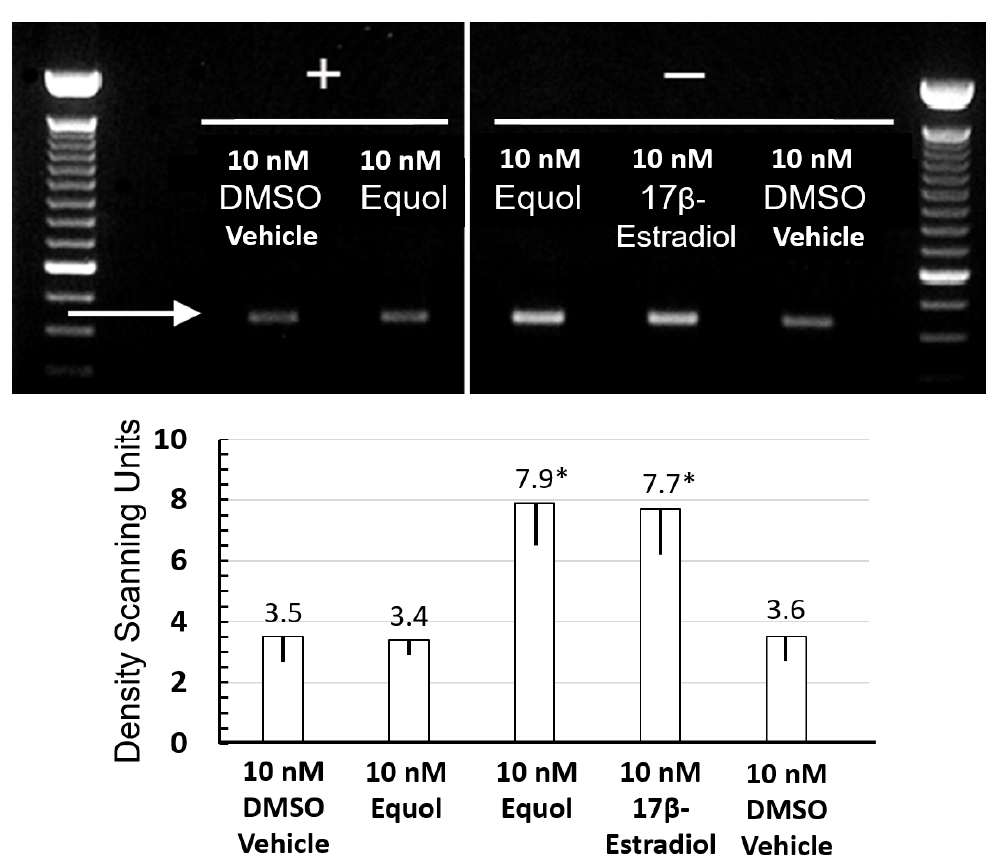
Figure 4. RT-PCR analysis of elastin gene expression in short-term (four days) human monolayer fibroblast cultures in the presence (+) or absence ( − ) of phenol red dye after treatment with 10 nM DMSO vehicle (control) or 10 nM Equol or 10 nM 17 β -Estradiol (top portion). The white arrow indicates the position of the 431 bp predicted elastin gene product. Molecular size ladders are shown on the far left and far right lanes. The bands by treatment were quantified by density scanning and shown in the lower portion of this figure (n = 3) per treatment. * = Significantly greater compared to DMSO control vehicle values in the absence of phenol red tissue indicator ( p < 0.05).